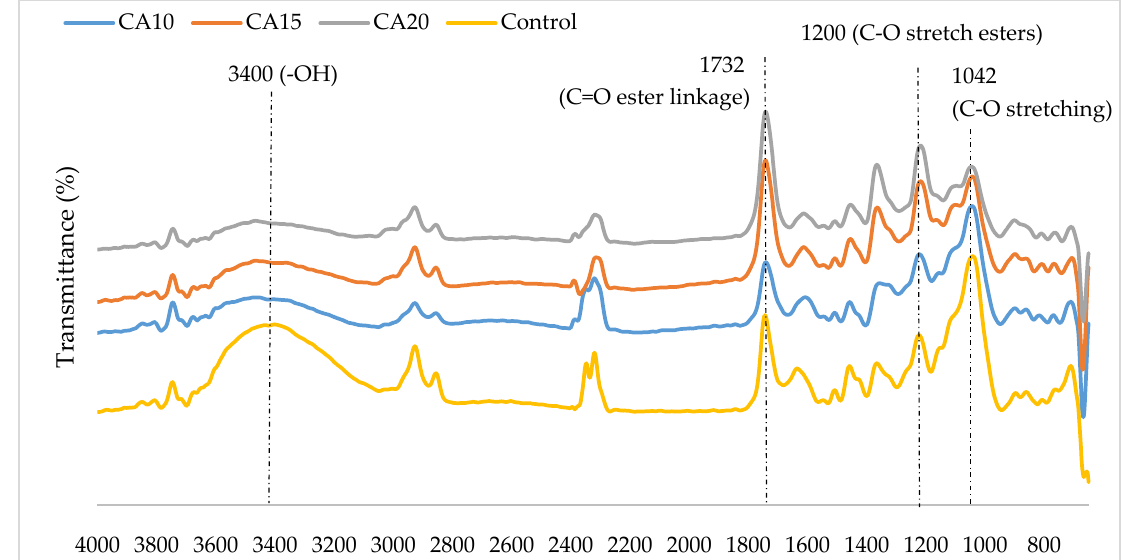
Figure 1. Fourier Transform Infrared (FTIR) spectra (4000 cm −1 –600 cm −1 ) of control and rubberwood particles sprayed with different citric acid content. CA10 = 10 wt% citric acid, CA15 = 15 wt% citric acid, CA20 = 20 wt% citric acid.